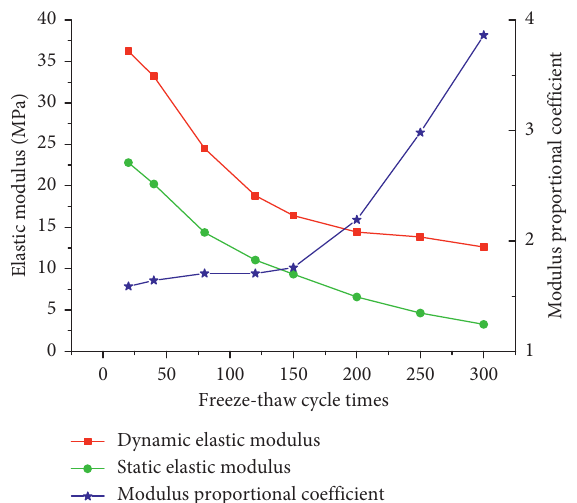
Figure 14: Variation rule of dynamic and static elastic modulus and modulus proportional coefficient with freeze-thaw cycles. Figure 16: Influence of input load on dynamic elastic modulus of rock mass under different freeze-thaw cycles.